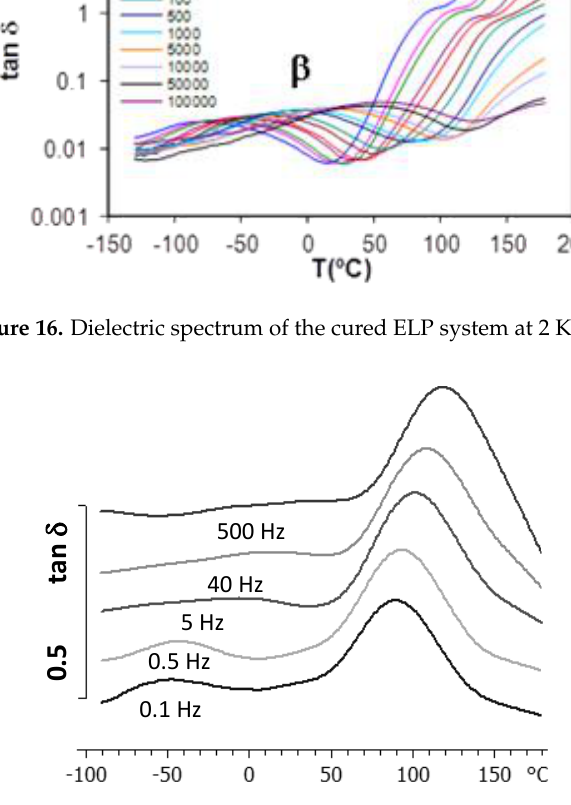
Figure 17. DMA spectrum of the cured ELP system at 2 K/min.